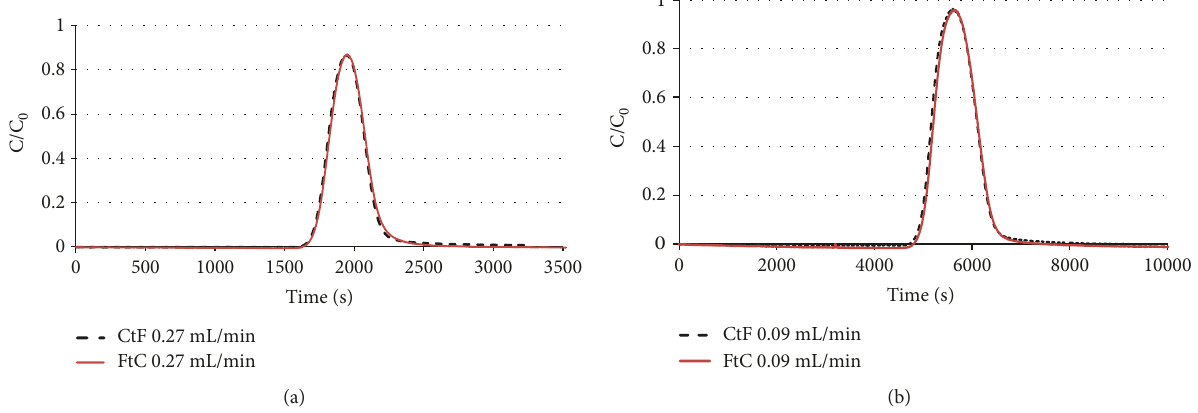
Figure 4: Breakthrough curves for the CtF and FtC experiments with the column #1 (FF and C bead sets) at two di ff erent fl ow regimes, source term 1.5mL: (a) 0.27mL/min, (b) 0.09mL/min.